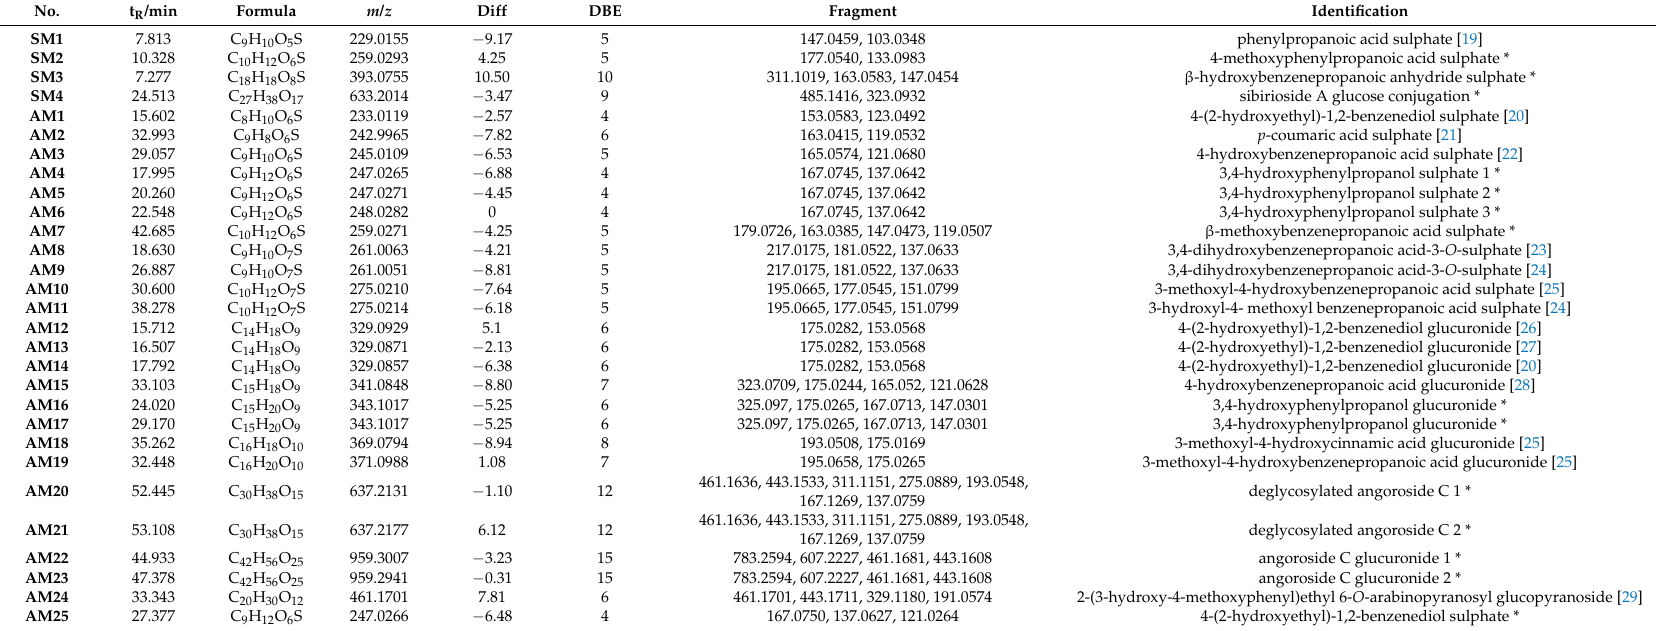
Table 1. LC-MS data obtained in the negative ion mode for the identification of the metabolites of sibirioside A and angoroside C in